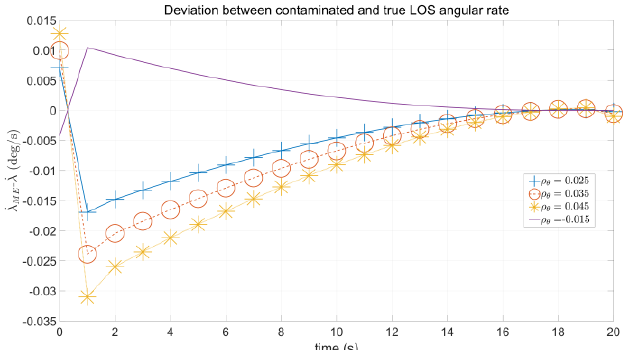
Figure 15. Deviation between the contaminated LOS angular rate λ with different values of the radome slope ρ θ .